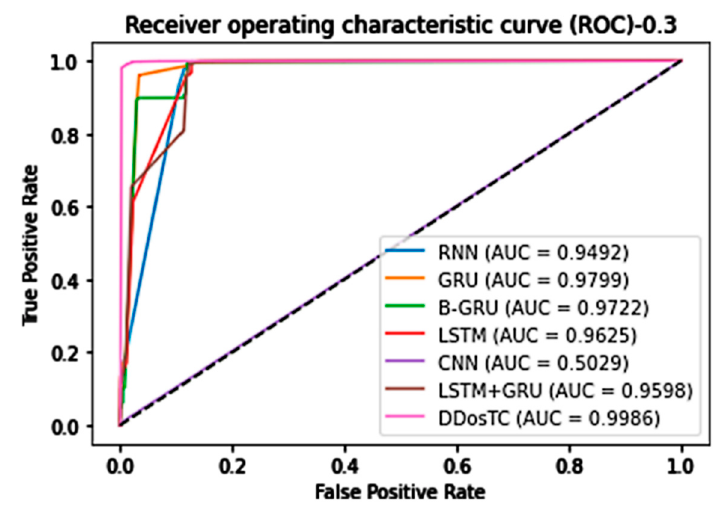
Figure 14. AUC for train/test = 6:4.